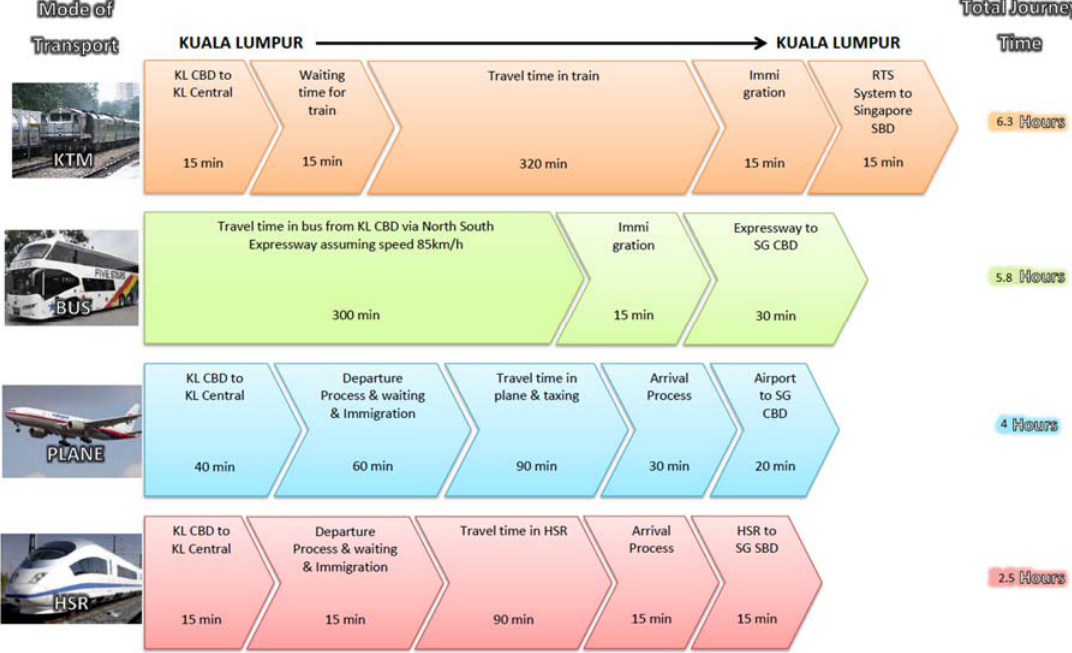
Figure 2. Travelling time from KL to Singapore: comparison between KTM, Bus, Plane and HSR (courtesy: SPAD).